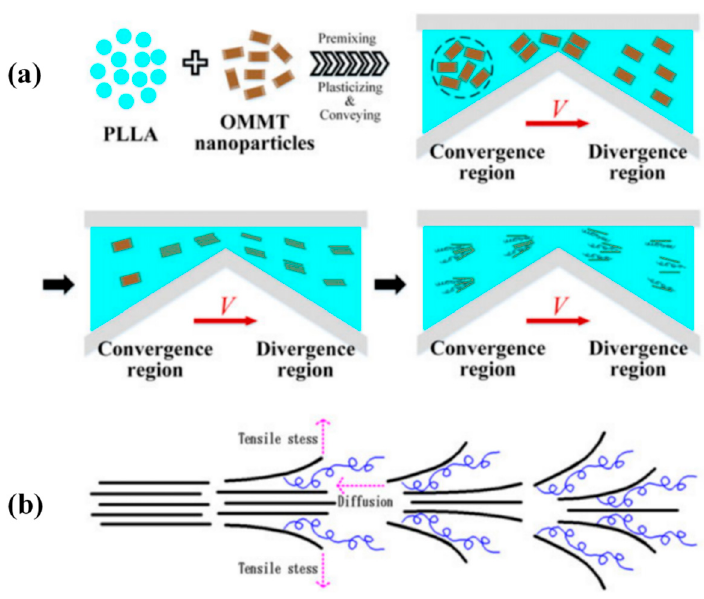
Figure 10. The Schematic illustration of ( a ) dispersion and exfoliation process of organically modified montmorillonite (OMMT) particles, and ( b ) double-side exfoliation mechanism. Reproduced with permission from [16]. Copyright 2017, John Wiley and Sons.